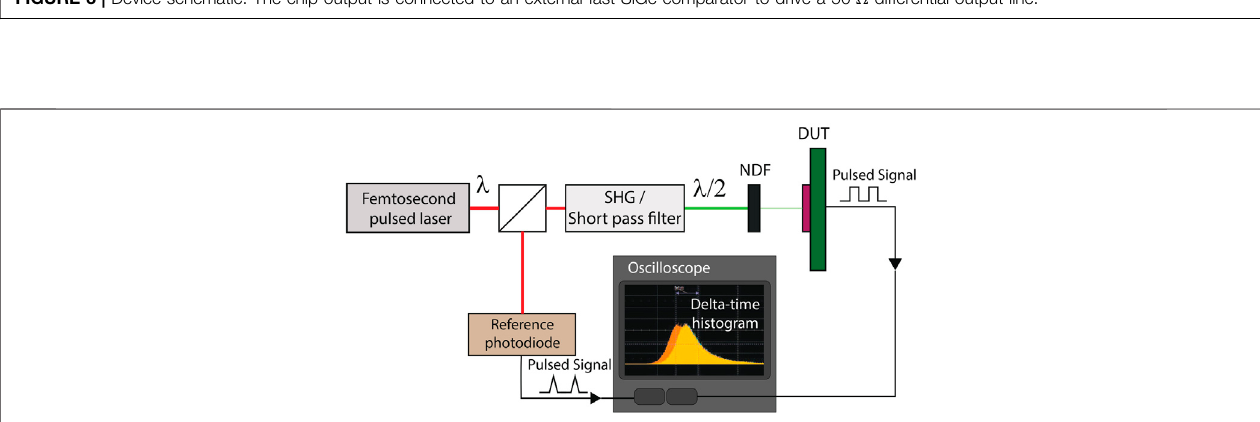
FIGURE 3 | Device schematic. The chip output is connected to an external fast SiGe comparator to drive a 50 Ω differential output line.